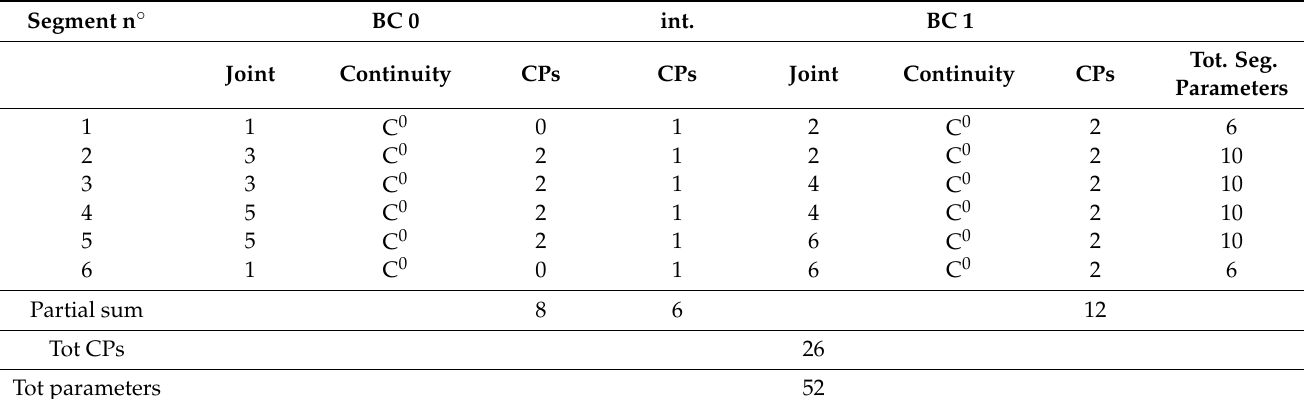
Table 2. Model parameters ensuring C 0 continuity (more model flexibility).